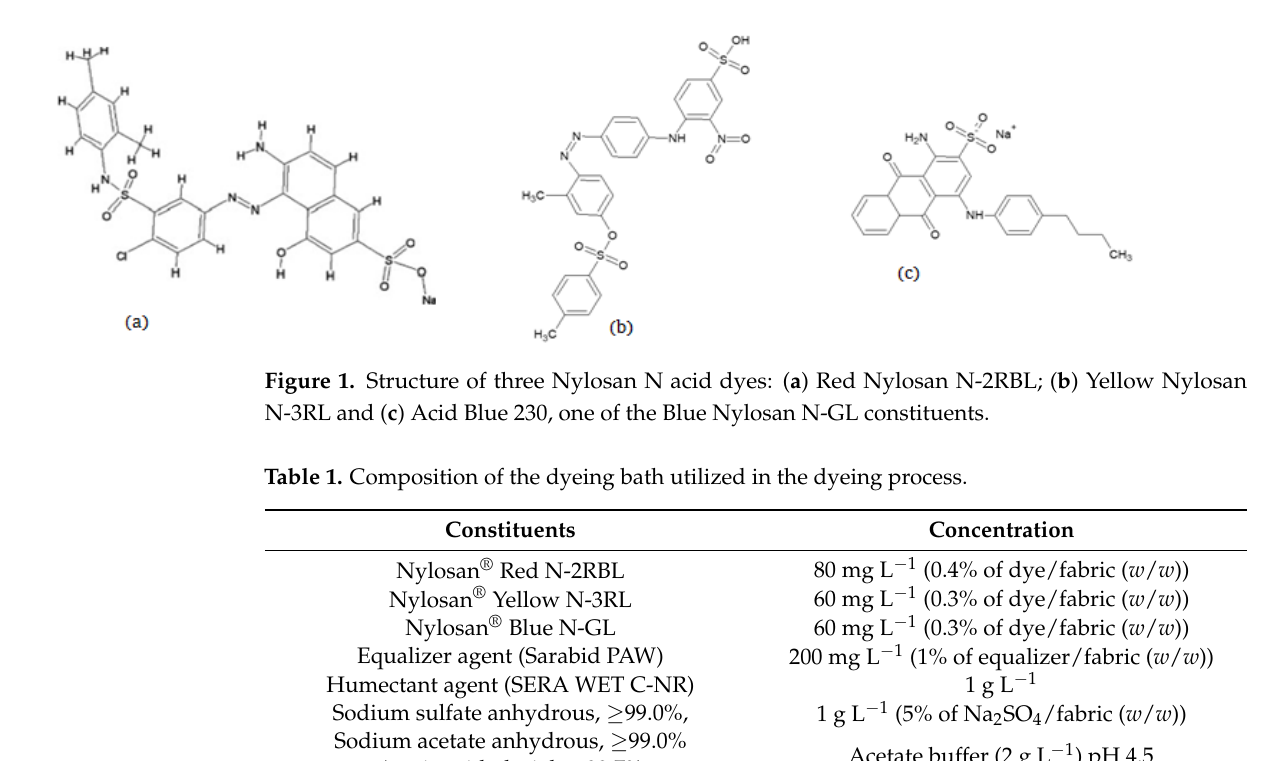
Table 1. Composition of the dyeing bath utilized in the dyeing process. Constituents